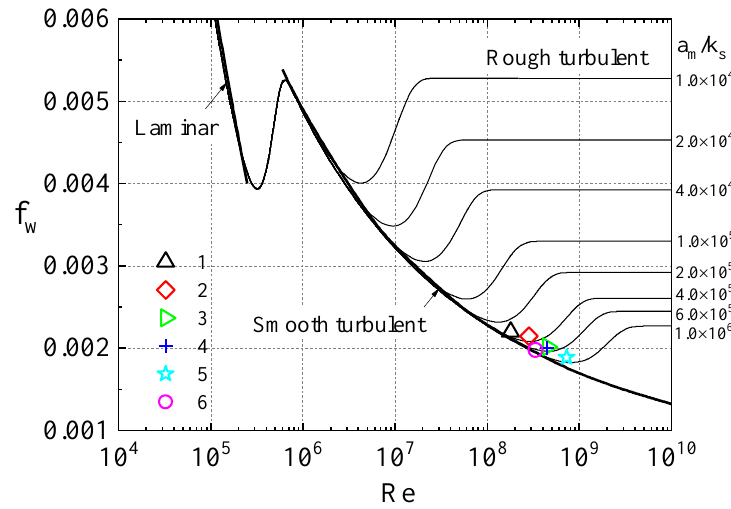
Figure 10. Wave friction coefficient.